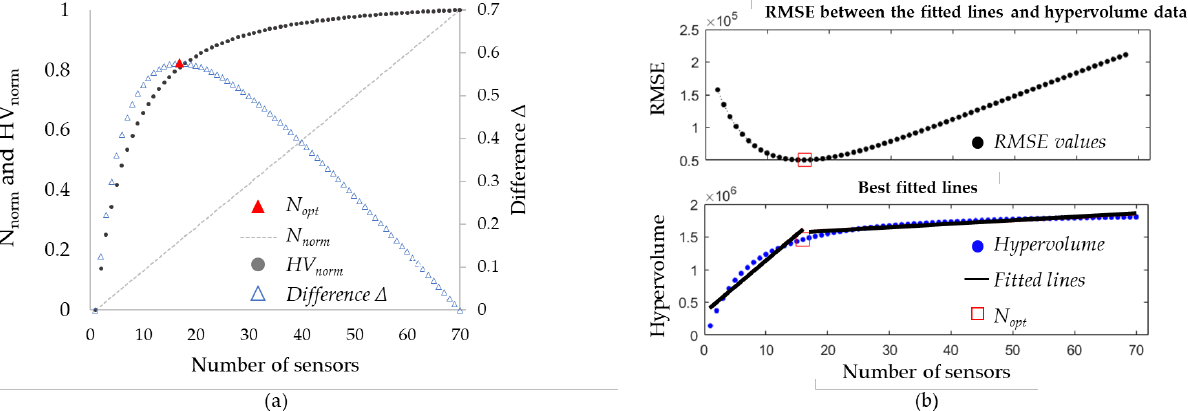
Figure 8. Optimal number of sensors for the F 5 function of Set 1 using ( a ) the Kneedle method and ( b ) the L-method.